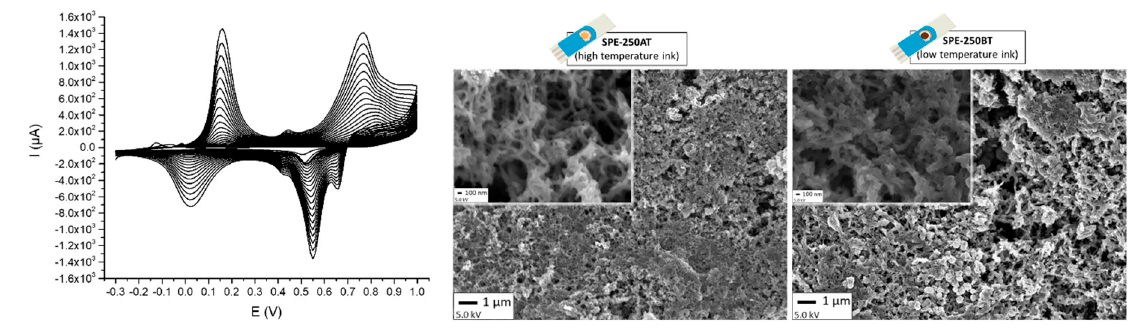
Figure 1. Morphology of PANI film deposited by cyclic voltammetry on two different commercial Au-SPE electrodes.